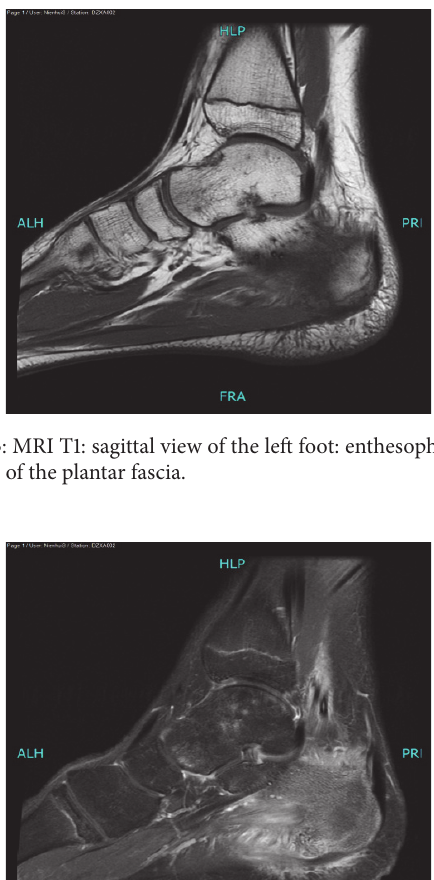
Figure 2: MRI T2 fat suppression: sagittal view of the left foot: high signal intensity of the soft tissue close to the plantar fascia.